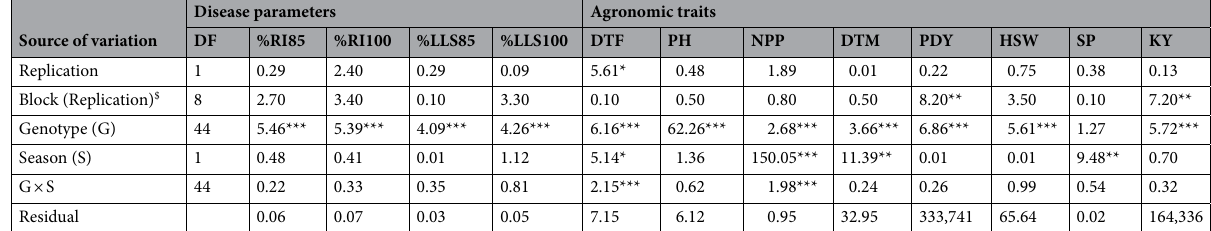
sampled plants in each plot from the soil surface to the tip of main stem. The number of pods per plant (NPP) was recorded as the average number of pods from ten randomly sampled and tagged plants per plot. Pod yield (PDY) was measured by weighing the dried pods from each plot and was recorded in grams per plot. Shelling percentage (SP) for each genotype was calculated from a random sample of pods weighing 200 g, as the pro- portion of shelled seed weight to the total weight of the unshelled pods. Additionally, 100 seed weight (HSW, expressed in grams) for each genotype was recorded as an average weight of two samples of 100 well-developed whole air-dried kernel per plot. Kernel yield (KY, expressed in t ha −1 ) was estimated as the weight of kernels harvested from a plot. Rust severity was scored at 85 days after planting (%RI85) and 100 days after planting (%RI100). The sever- ity was scored using a scale of 1 (least affected) to 9 (most affected) following 34 . Plants with no symptoms of infection were assigned a disease score of 1 (for 0% infection) while leaves with 1–5% infection were assigned a score of 2, 6–10% infection (score 3), 11–20% infection (score 4), 21–30% (score 5), 31–40% infection (score 6), 41–60% infection (score 7), 61–80% infection (score 8) and 81–100% infection (score 9) 35 . Plants with a